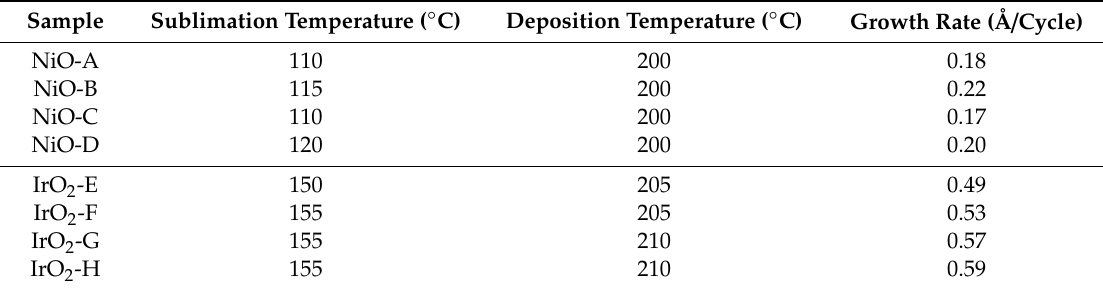
Table 2. Sublimation, deposition temperature, and growth rate of the electrode materials.